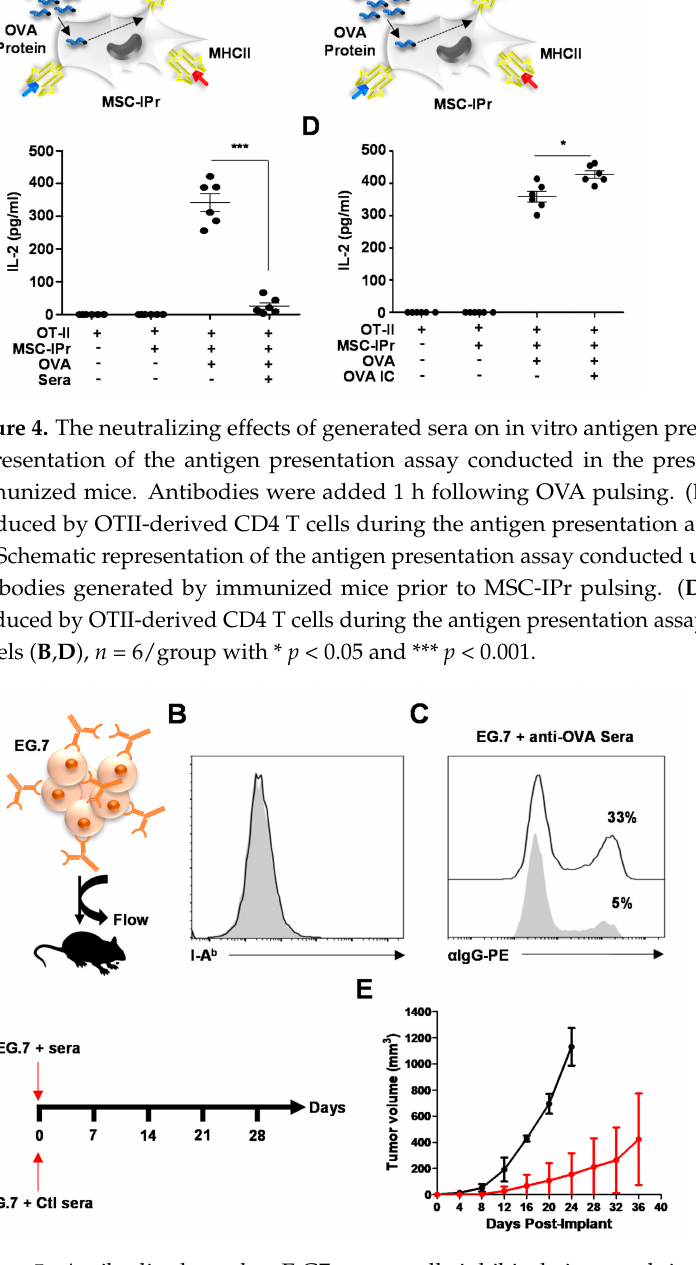
Figure 5. Antibodies bound to E.G7 tumor cells inhibit their growth in vivo. ( A ) Schematic rep- resentation of the study design. ( B ) Representative flow cytometry analysis of E.G7 I-A b levels. ( C ) Representative flow cytometry analysis of E.G7 cell surface-bound antibodies. Treatment of E.G7 cells with the pre-immune sera is shown in light grey whereas OVA-specific sera cells are in plain white. ( D , E ) Schematic diagram ( D ) of the in vivo experiment conducted using E.G7 tumor cells incubated with antibodies generated by mice immunized using OVA-pulsed MSC-IPr before being transplanted SC in immunocompetent C57BL/6 mice ( E ). E.G7 treated with Ctl sera is shown in black whereas E.G7 mixed with sera isolated from mice immunized using OVA-pulsed allogeneic MSC-IPr is depicted in red. For panel D, n =